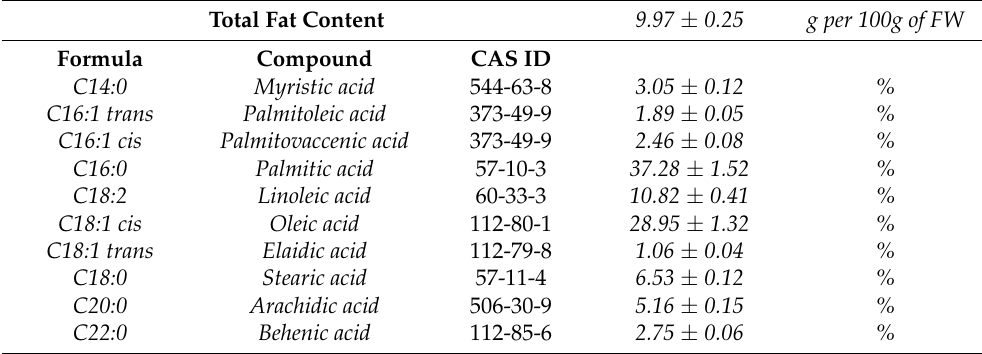
Table 3. Identification and Quantification of Fatty Acids in F1-BEO. CAS ID: Chemical Abstracts Service Identification number.